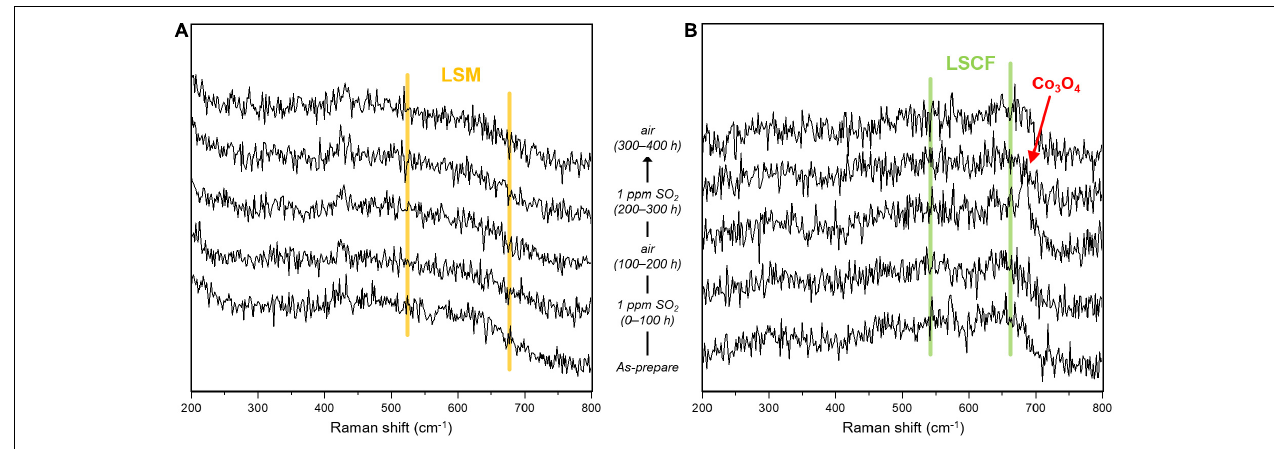
FIGURE 7 | Raman spectra of (A) LSM and (B) LSCF exposed to an alternating atmosphere of air and 1 ppm SO 2 (air balance) for 400 h at 700 ◦ C.